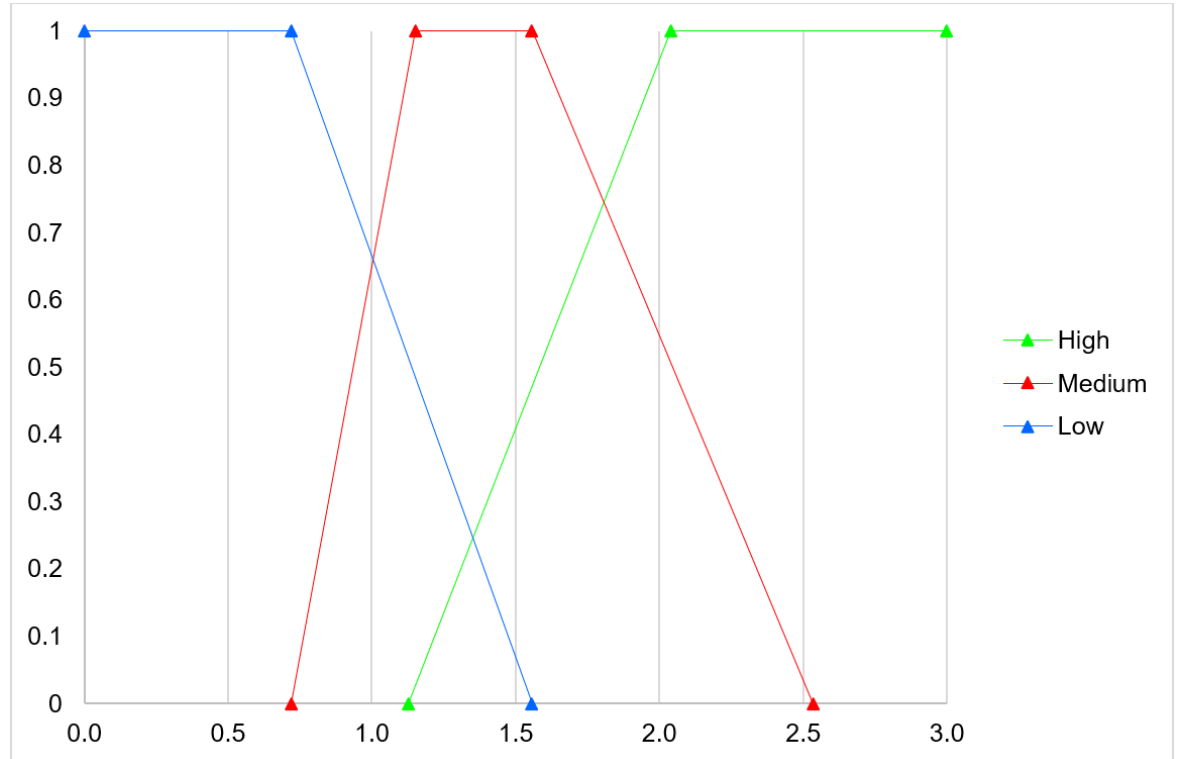
Figure 8. Membership functions of the importance of stakeholders’